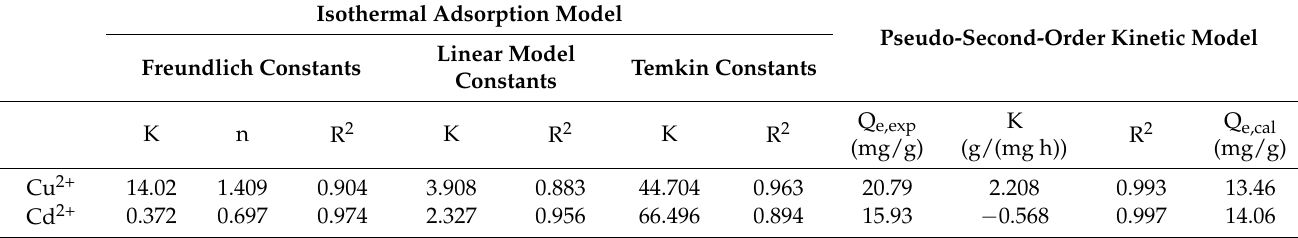
Table 4. Model parameters of the EPS adsorption of Cu 2+ and Cd 2+